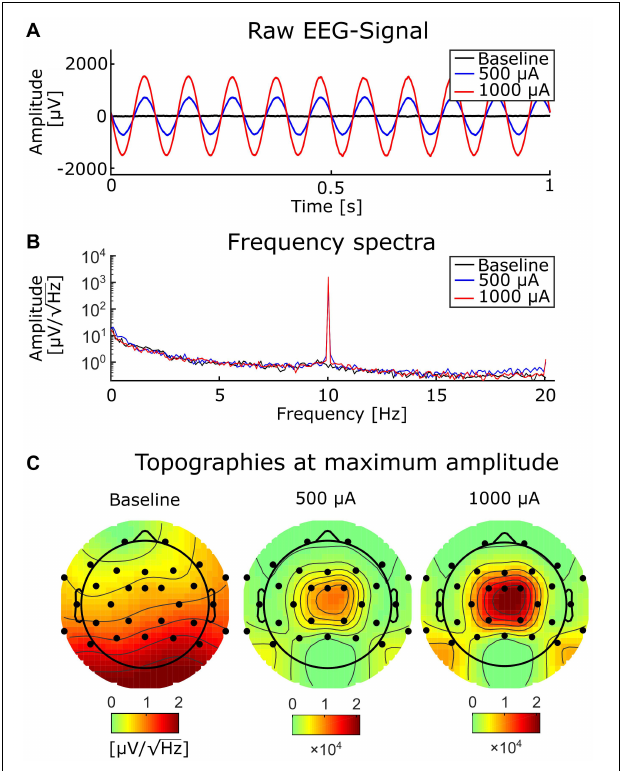
FIGURE 6 | Baseline EEG and tACS-contaminated EEG. (A) A representative segment of EEG without tACS (black), and with simultaneous tACS at 500 (blue) and 1,000 µ A (red). (B) Frequency spectra at 0.2-Hz resolution from the same conditions as in (A) and with the same color conventions. (C) Topographies of the baseline EEG (left) and the EEG contaminated by tACS with 500 (mid) and 1,000 µ A